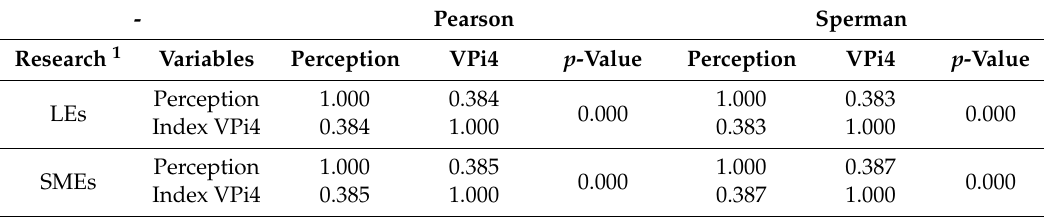
Table 8. Relation to subjective perception of Industry 4.0, based on Pearson and Spearman coe ffi cients. -